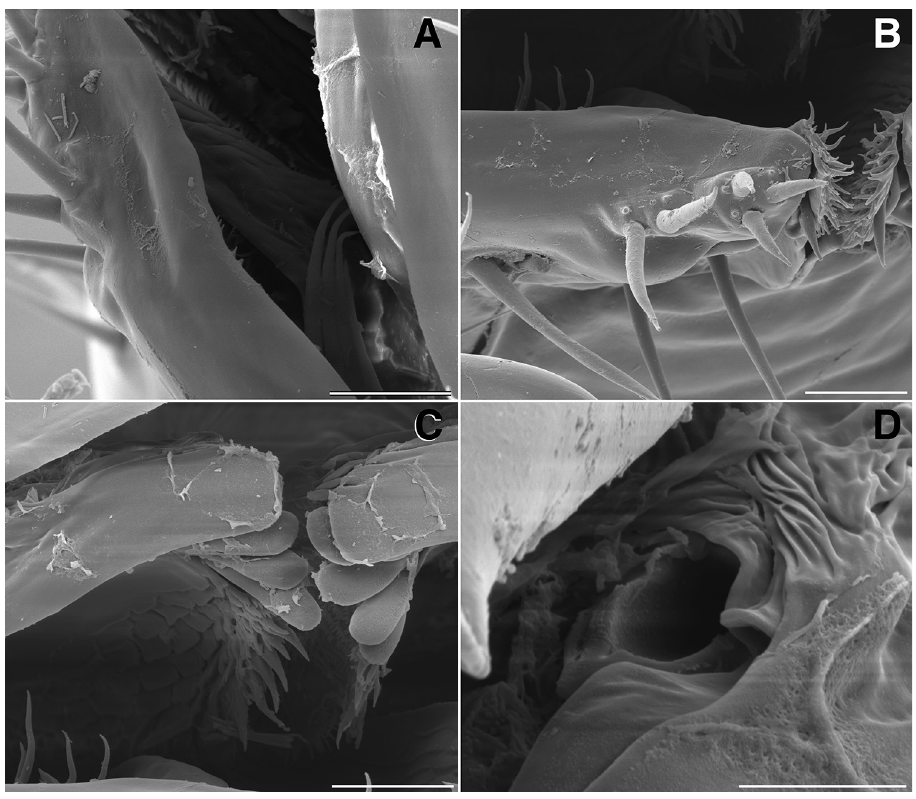
Figures 14. Illacme tobini sp. n.: A anterolateral (left) view of gnathochilarial stipes and dorsal surface of endochilarium (scale bar 10 µm) B anterior view of gnathochilarium with inner and outer palps (inner, outer palps with 3, 2 setae respectively) (scale bar 10 µm) C anterolateral (right) view of open mouth and keel-shaped pectinate lamella of the mandible (scale bar 10 µm) D anterolateral (right) view of mandible with base of external teeth a circular socket (scale bar 4 µm). (Catalog #: I. tobini sp. n.